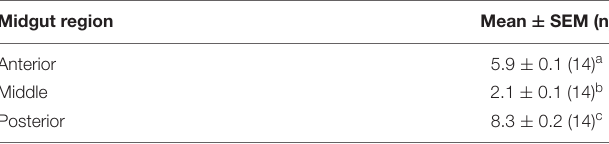
TABLE 1 | pH values in the lumen of the midgut regions of H. illucens larvae.